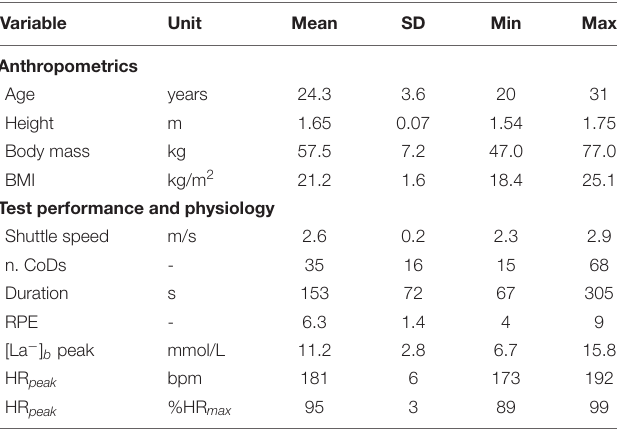
TABLE 1 | Participants’ anthropometrics and test (continuous shuttle run)